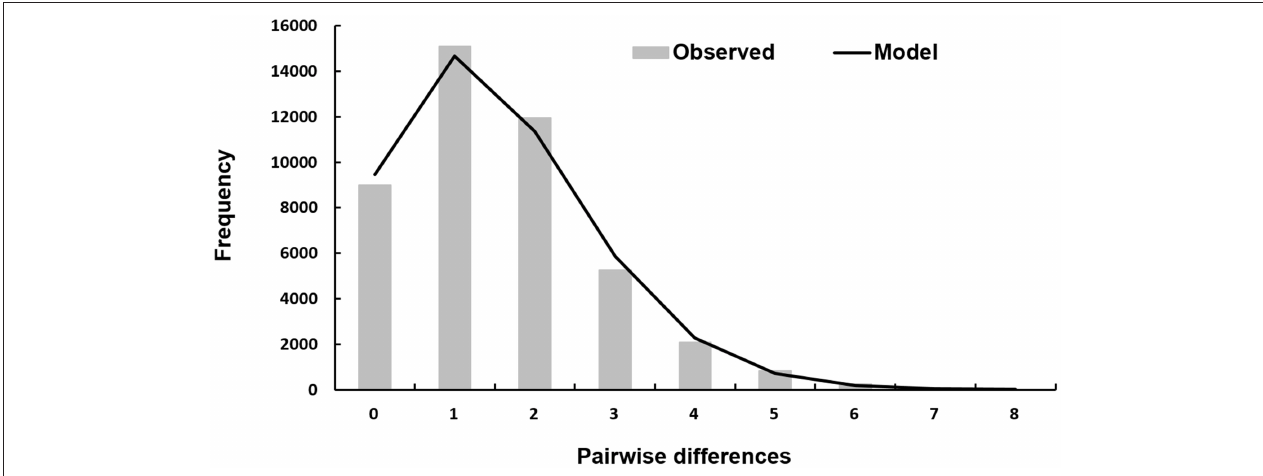
FIGURE 4 | Mismatch distribution of DS 1. Observed pairwise differences between 299 sequences for DS 1 (bars) and the expected mismatch distributions under the sudden expansion model (solid